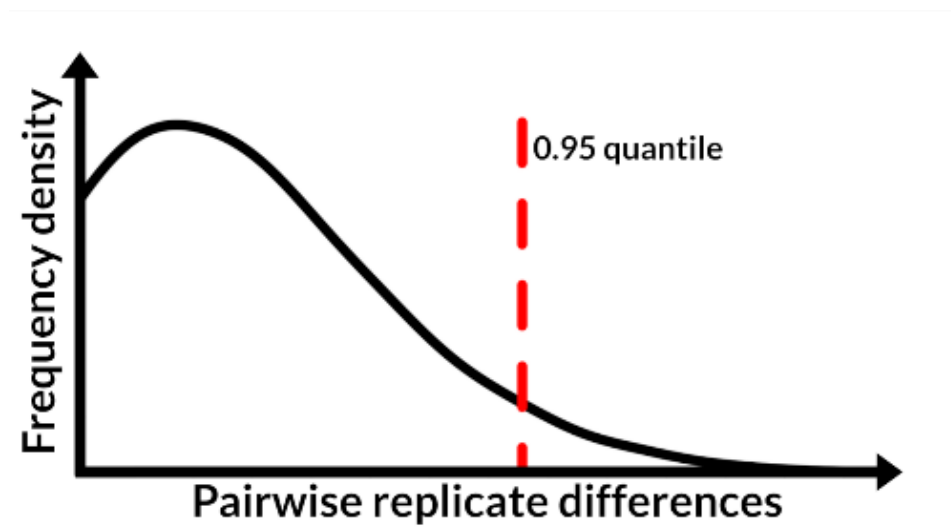
Figure 2. Visual representation of the outlier detection approach implemented in the ‘pw_outlier()’ function. Given a peak area matrix for a particular compound or feature, all pairwise differences between sample replicates are computed. The distribution of these differences is expected to be positively skewed, with values surpassing a given quantile threshold (0.95% shown) marked as potential outliers.